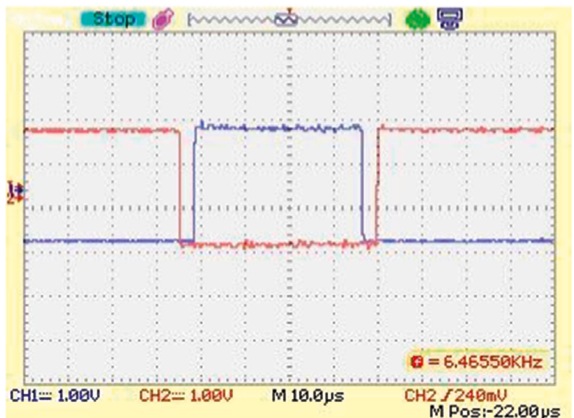
Figure 27: Driving part working local